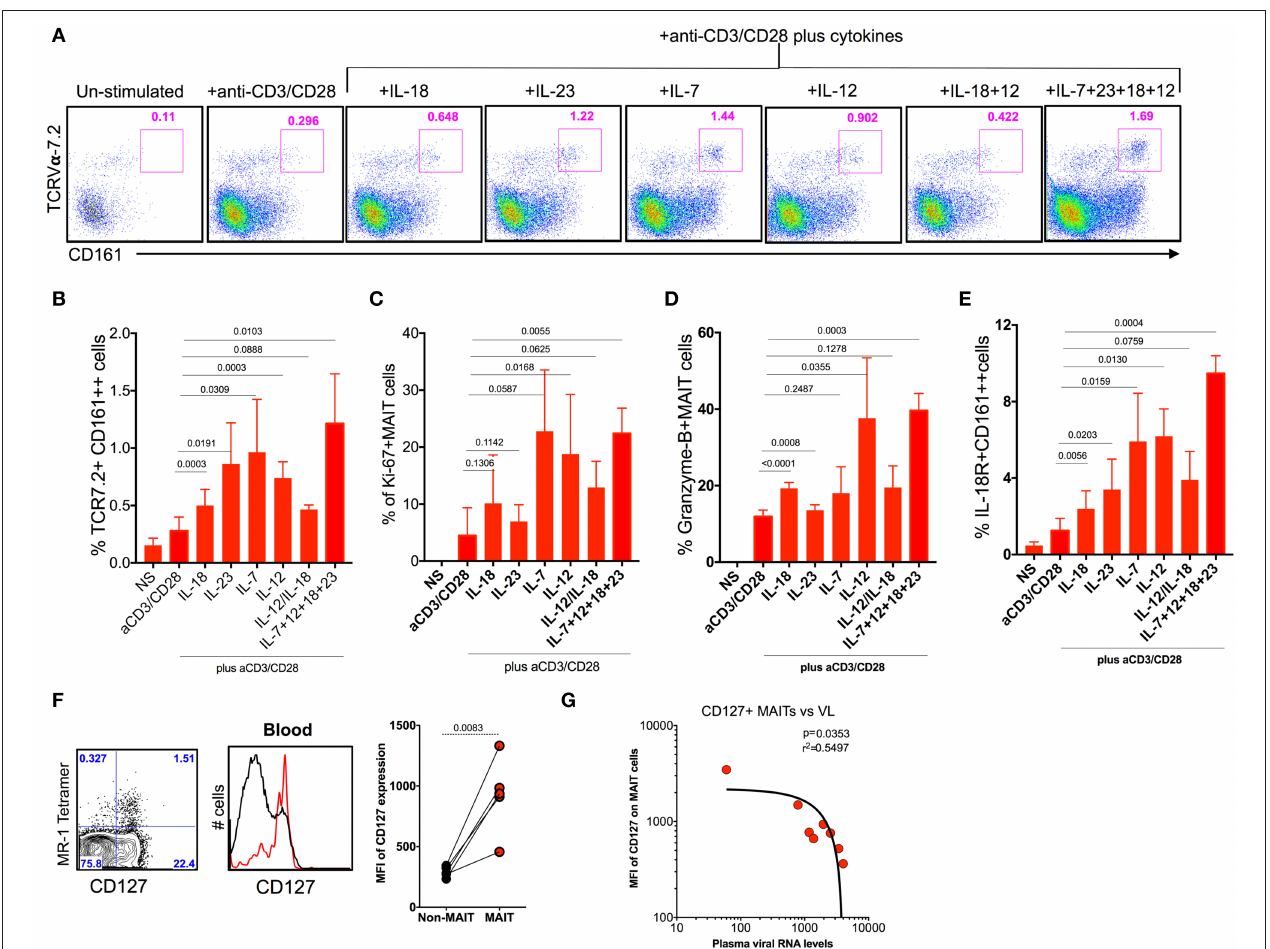
FIGURE 7 | Cytokine IL-7 maintains the proliferation, and IL-12 and IL-18 maintain the cytotoxic capacity of MAIT cells. (A) Representative flow plots showing the induction of MAIT cell markers after anti-CD3/anti-CD28 stimulation with and without the addition of cytokines. (B) Plots showing the cumulative data for the frequency of MAIT cells after anti-CD3/anti-CD28 stimulation with and without the addition of different cytokines. (C) Plots showing the frequency of proliferating MAIT cells after anti-CD3/anti-CD28 stimulation with and without the addition of different cytokines. (D) Plots showing the frequency of granzyme-B + MAIT cells after anti-CD3/anti-CD28 stimulation with and without the addition of different cytokines. (E) Plots showing the frequency of IL-18R expressing MAIT cells after anti-CD3/anti-CD28 stimulation with and without the addition of different cytokines. (F) Representative flow plots showing the expression of IL-7R on MAIT cells. (G) IL-7R expressing MAIT cells correlates inversely with plasma viral RNA levels ( n =